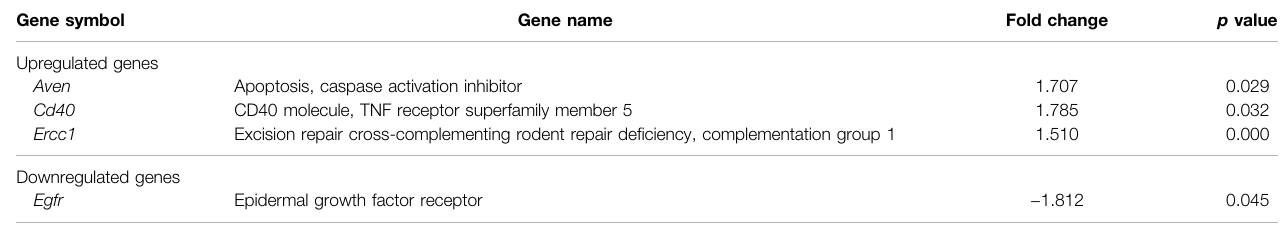
TABLE 3 | Effects of gestational and lactational low-protein diet on gene expression in female offspring mammary gland after a single MNU administration at PND 28 a . Gene symbol Gene name Fold change Upregulated genes